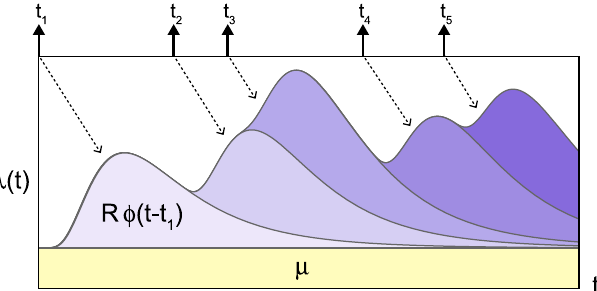
Fig 1. Schematic description of the Hawkes process Eq (1). The occurrence rate λ ( t ) is increased according to past ( k = 1, 2, ... ) with the transmission delays t − t events occurred at times t = t k reproduction number that represents the average number of events induced by a single